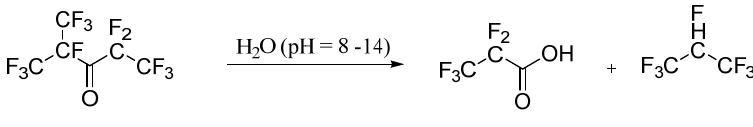
Figure 2. Hydrolysis reaction of C 6 F 12 O.